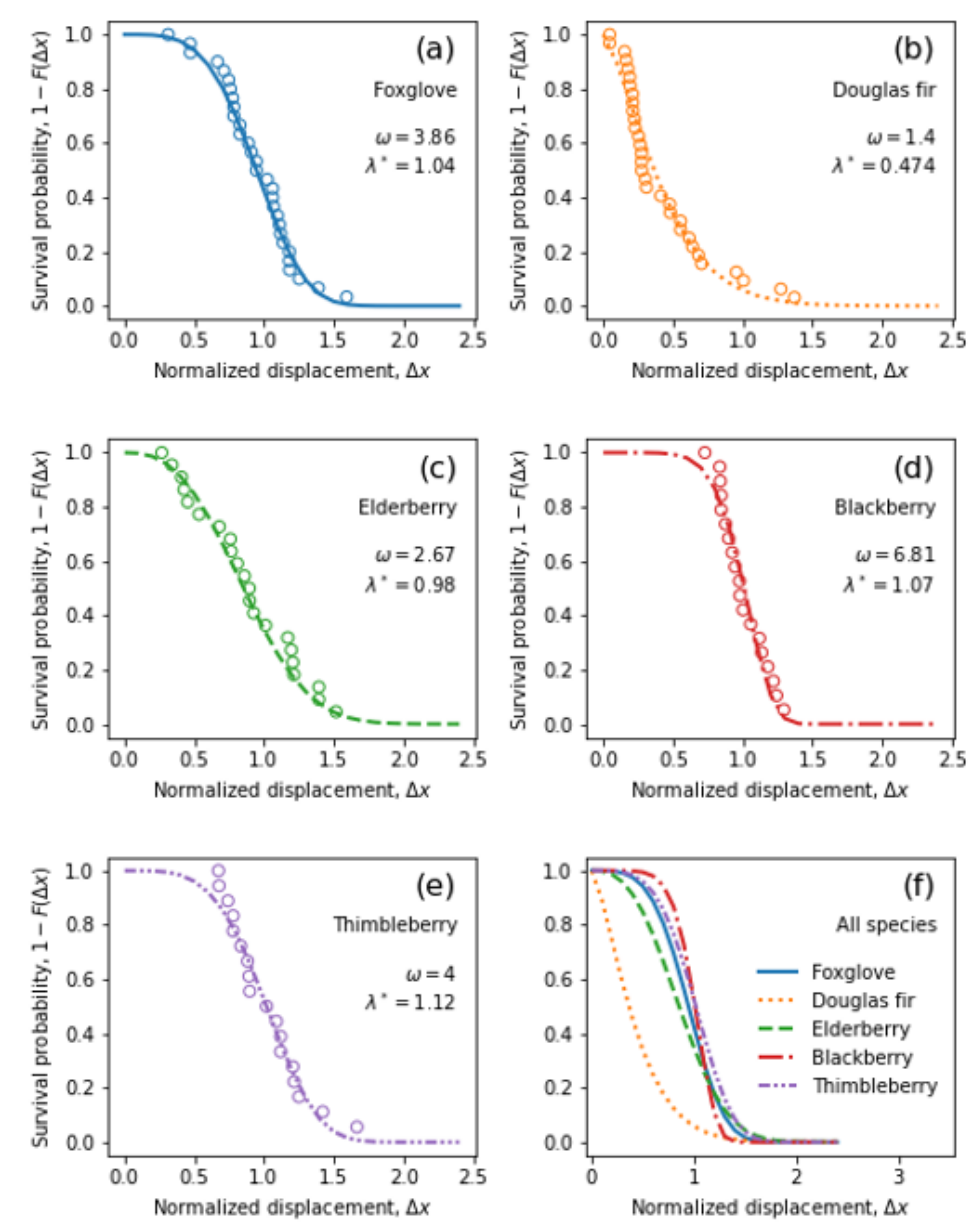
Figure 7. Estimated normalized displacement data (circles) and curve from the fitted Weibull survival function (see Appendix B). Estimated normalized displacement and fitted Weibull survival curves are shown for foxglove ( a ), Douglas fir ( b ), elderberry ( c ), blackberry ( d ), and thimbleberry ( e ). Panel ( f ) shows the estimated normalized displacement and the fitted Weibull survival curves for roots of all species plotted together.